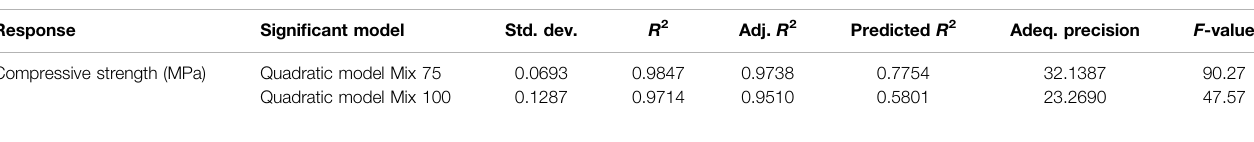
TABLE 11 | Fit summary results for Mix 75 and Mix